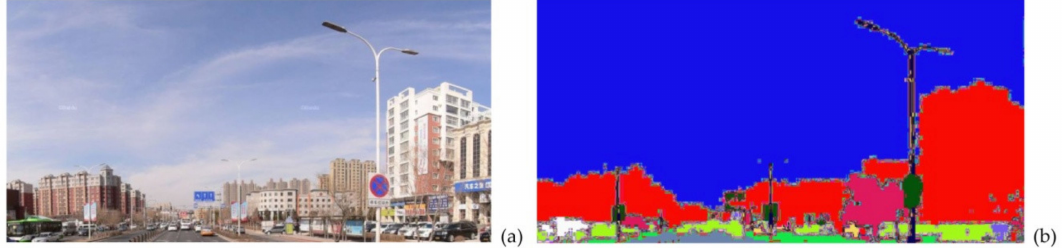
Figure 5. Example of the street view image segmentation results.